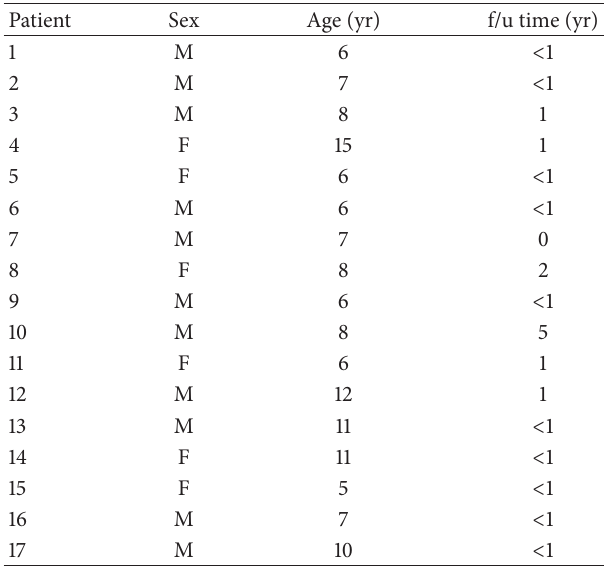
Table 1: Patient demographics.